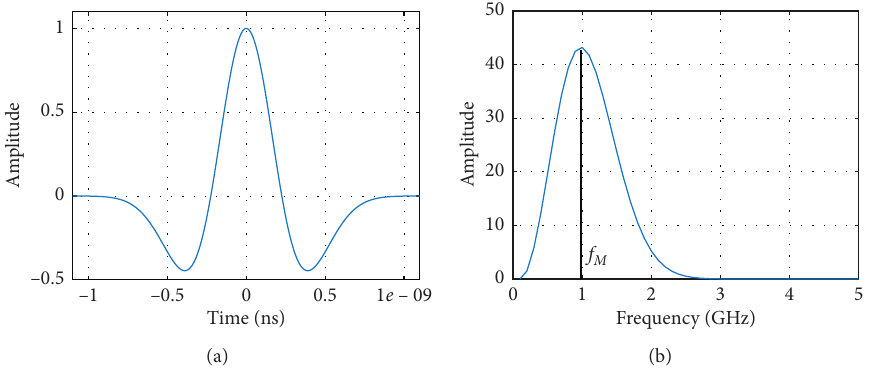
Figure 3: Time and frequency curve of the Ricker wavelet: (a) time domain; (b) frequency